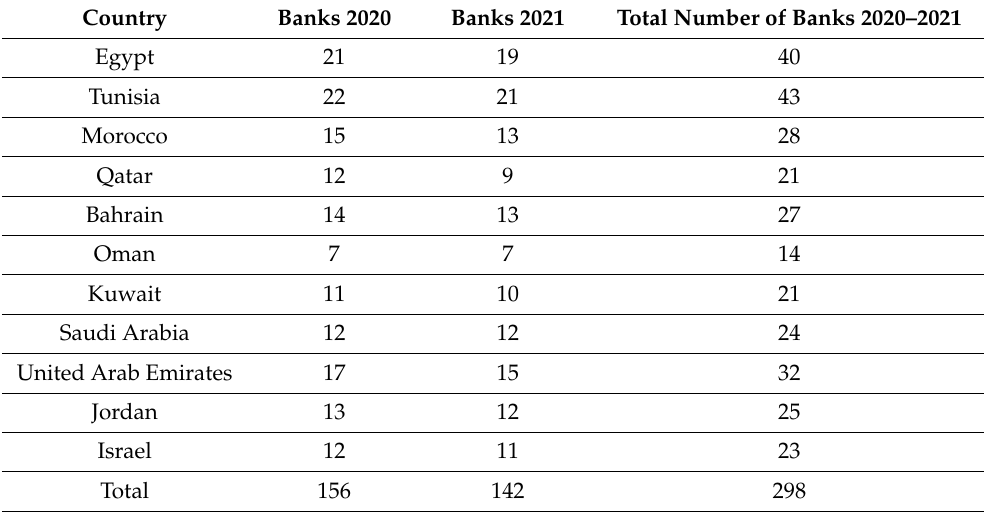
Table 5. Research sample of MENA